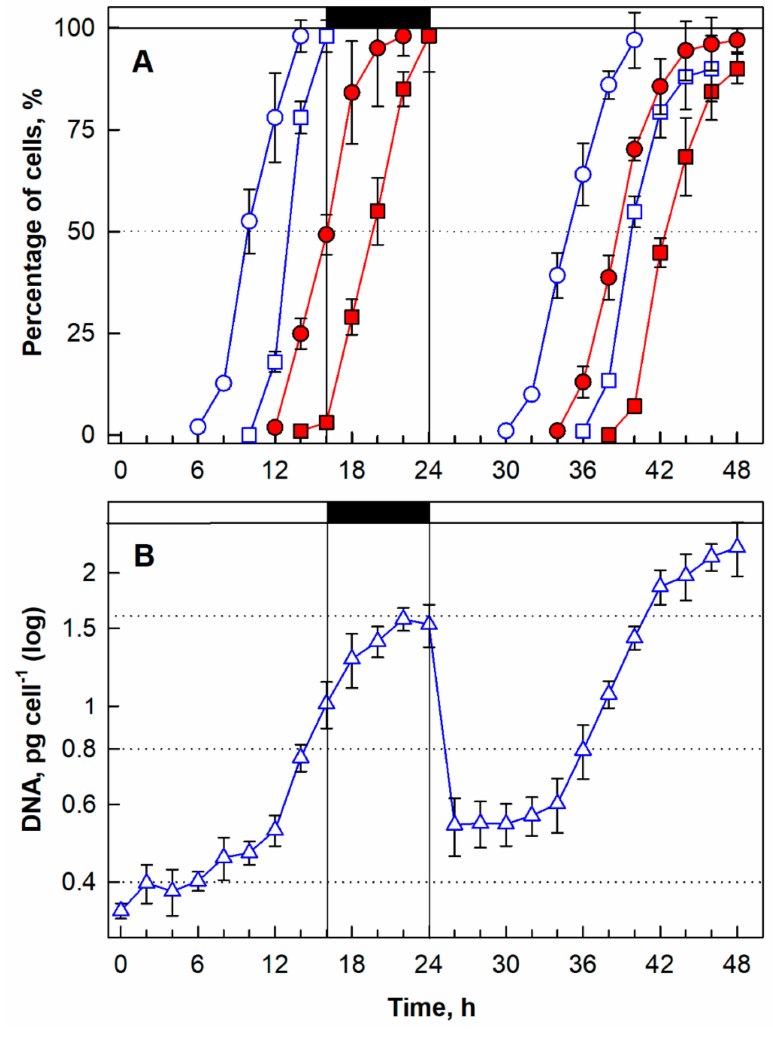
Figure 4. Cell cycle progression in a synchronized culture of Galdieria sulphuraria grown at 500 µ mol photons m − 2 s − 1 , 40 ◦ C, pH 3. Panel ( A ): Blue lines: percentage of cells that attained the commitment point for the first (circles) and second (squares) sequence of reproductive events. Red lines: Percentage of cells that completed the first (circles) and second (squares) nuclear and cellular divisions. Cells divided into 4 daughter cells. Pane ( B ): DNA synthesis in pg cell − 1 . Dark phase is indicated by the black bar. The data are plotted as means of biological triplicates. The error bars represent standard deviations ( ± SD) and are shown when they are larger than the symbol